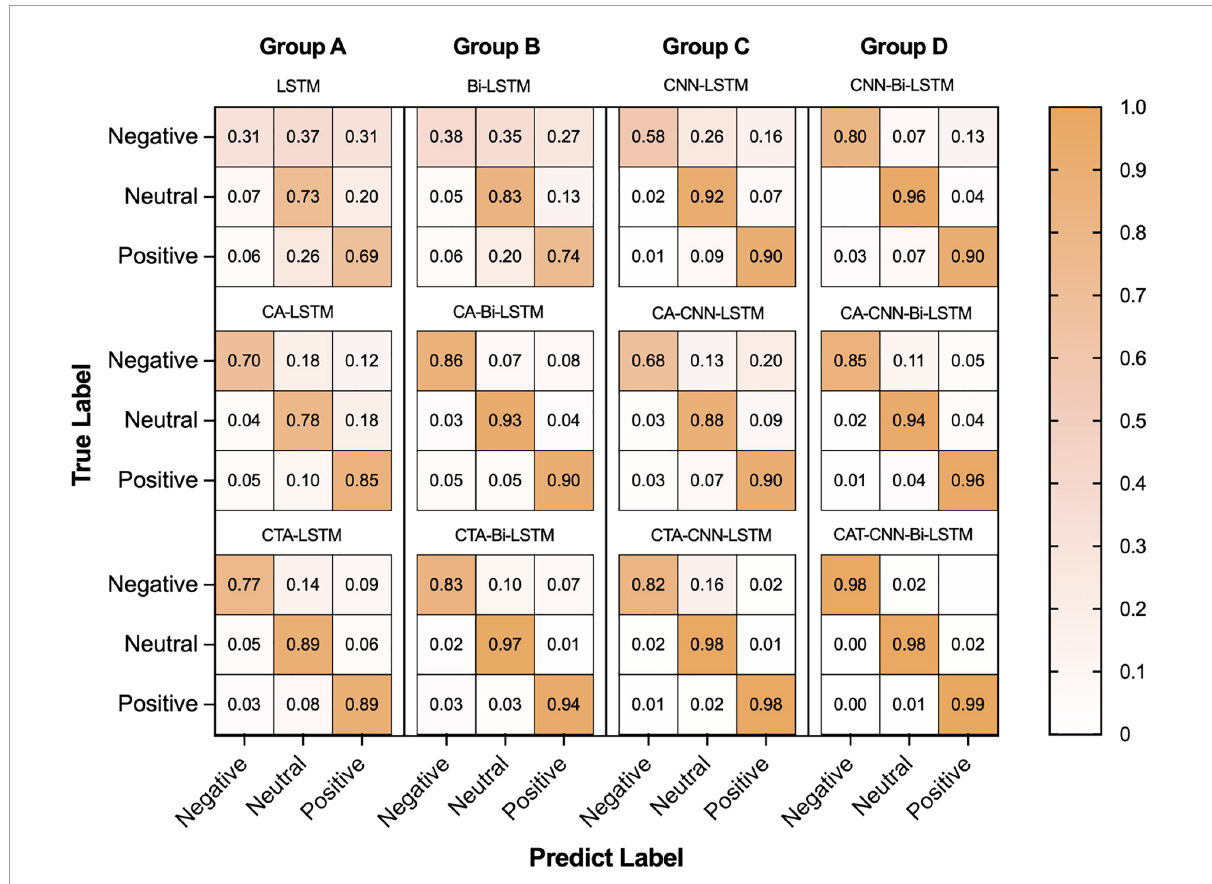
FIGURE6 The result of confusion matrixes of negative, neutral, and positive emotions in baseline and proposed